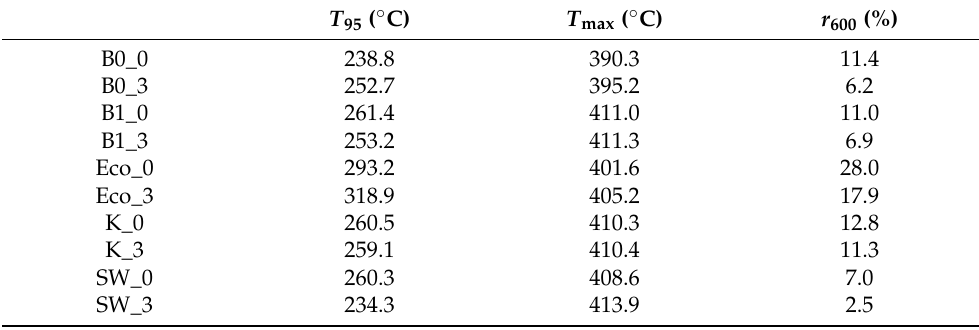
Table 7. TGA results of studied films; onset degradation temperature ( T 95 ), temperature of maximum degradation rate ( T max ), and the char residue at 600 °C ( r 600 ).